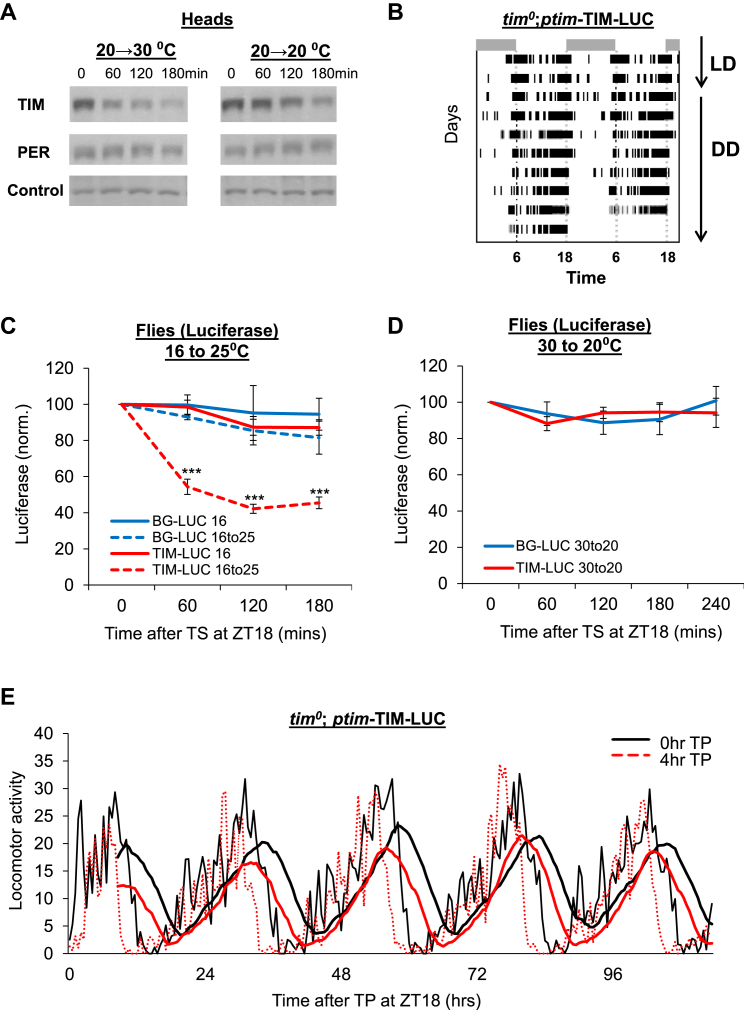
Temperature Degrades TIMELESS and Shifts the Circadian Clock, Related to Figure 1(A) Representative Western blots from Drosophila heads show that TIM is specifically degraded after TS, while PER is not affected. An unspecific band is shown for loading control.(B) Expression of TIM-LUC fusion protein under 4.6 kb tim promoter restores normal rhythmicity to TIM null (tim0) flies and has no effect when expressed in a wild-type background (not shown).(C) A temperature pulse from 16°C to 25°C also degrades TIM (red) in a specific manner in TIM-LUC flies, while it has no effect on PER (blue).(D) A cold shift from 30°C to 20°C has no specific effect on TIM (red) and PER (blue) in flies.(E) Locomotor behavior recordings of control (non-pulsed, black) and temperature-pulsed TIM-LUC flies (red) with 6 hr moving average traces are shown. Phase advance induced by Temperature pulse (TP) is measured by comparing at least three corresponding troughs from average traces of at least 8 flies, which we found is the most reliable phase marker Error bars: SEM for (C and D). p < 0.05 or p < 0.001 from at least four independent experiments (n ≥ 6 each) is indicated with “∗” or “∗∗∗,” respectively.